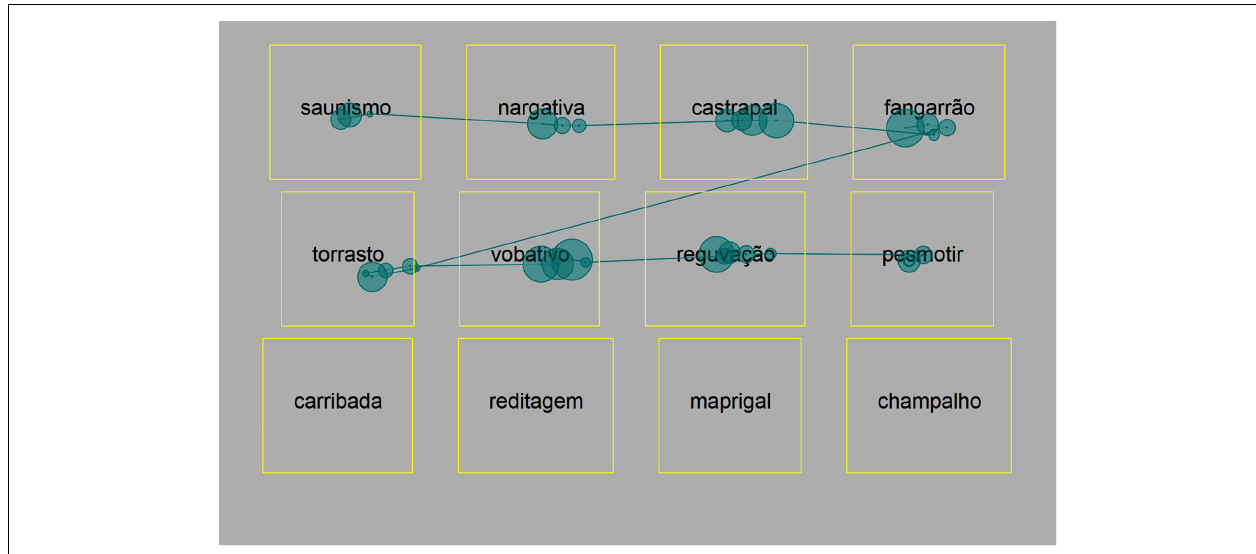
FIGURE 2 | Example list (long pseudowords). Participants read the items in lines, as indicated by the example scanpath. Items in the first column, as well as the last item (“champalho”) did not enter the analysis. Rectangles around each item indicate the AOIs, which were not visible during the experiment.